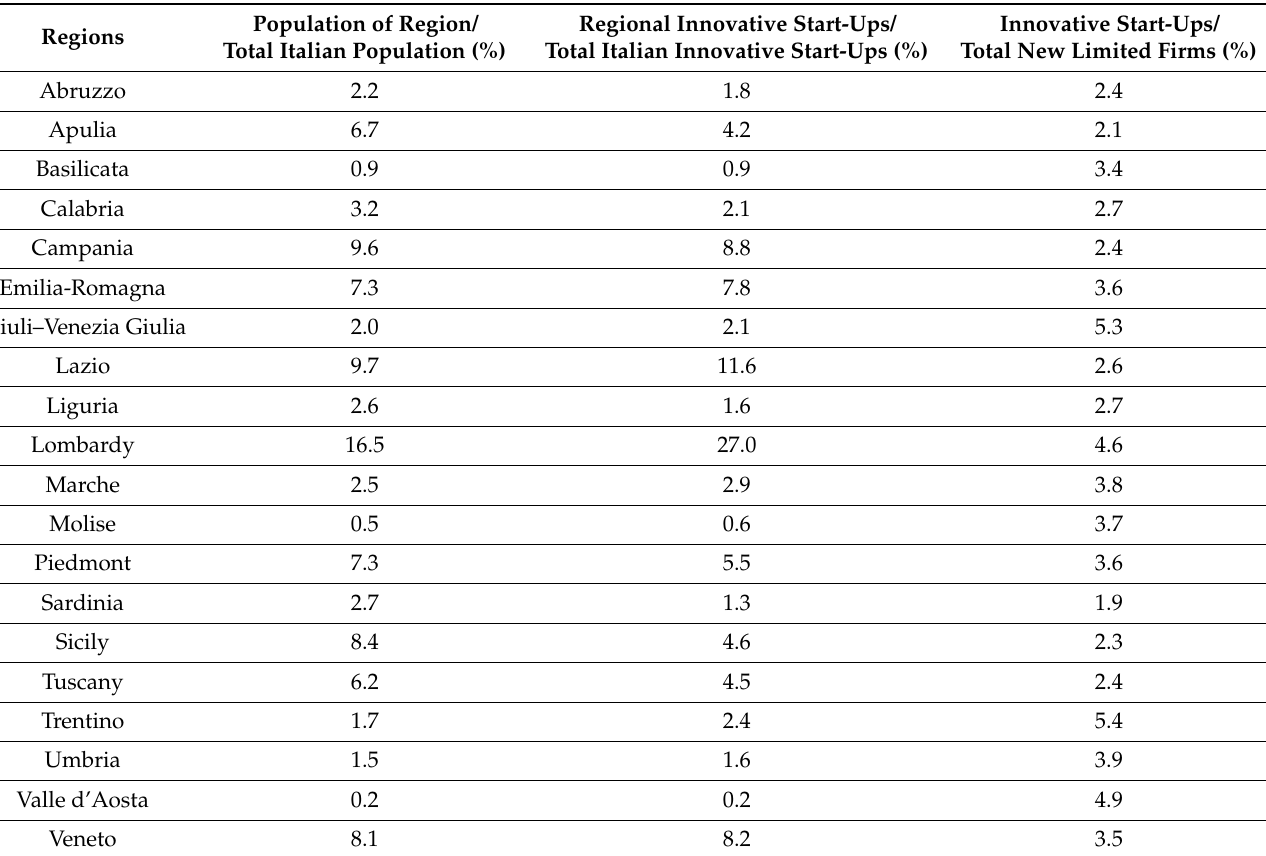
Table 1. Descriptive analysis of Italian Innovative Start-ups: regional distribution and density,